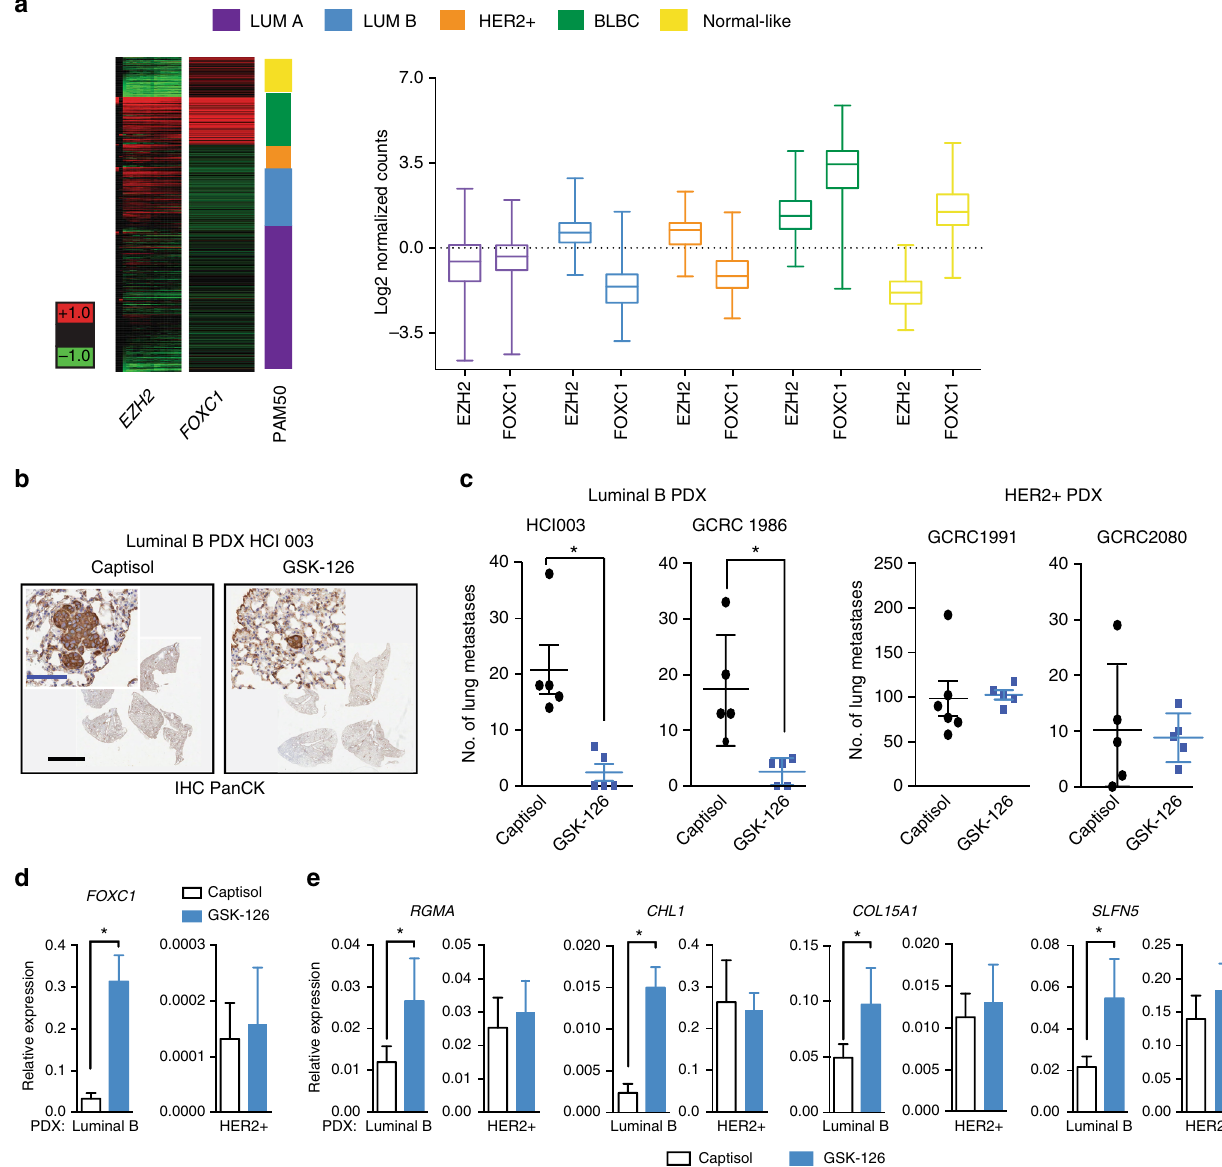
Fig. 7 Inhibition of Ezh2 methyltransferase activity reduces the metastatic capacity of Luminal B but not HER2 breast cancer. a FOXC1 or EZH2 transcript levels across different PAM50 subtypes of breast cancer represented in a heat map. Turkey box plots showing median EZH2 or FOXC1 levels across different breast cancer subtypes. Data is from the TCGA Breast Cancer data set, publicly accessible via the XENA UCSC Cancer Genome Browser. Dotted Red outline denotes Luminal B subset. Normal-like (yellow), n = 119, EZH2 s.d = 0.72, mean = 1.54, FOXC1 s.d = 1, mean = − 1.64. BLBC (green), n = 142, EZH2 s.d = 0.81, mean = 1.3, FOXC1 s.d = 1,27, mean = 3.18. HER2 (orange), n = 67, EZH2 s.d = 0.73, mean = 0.63, FOXC1 s.d = 0.84, mean = − 1.13. Luminal A (purple), n = 434, EZH2 s.d = 1.08, mean = − 0.64, FOXC1 s.d = 0.83, mean = − 0.44. Luminal B (blue) n = 194, EZH2 s.d = 0.65, mean = 0.60, FOXC1 s.d = 0.89, mean = − 1.64. Whiskers for the plots signi fi y s.d, while the bar denotes the mean for each subtype. b Representative images of paraf fi n-embedded sections of lung stained with pan cytokeratin (pan CK). Lung lesions were identi fi ed by pan CK positivity and enlarged nuclei. Top scale bar is 200 μ m. Bottom scale bar is 5 mm. c Quanti fi cation of lung lesions following the implantation of Luminal B PDX (HCI003) or HER2 + PDX (GCRC1991) into the mammary fat pad, followed by treatment with GSK-126 or vehicle (Captisol). N = 5 per condition. * p < 0.05, 1 tailed t -test. d qRT-PCR analysis of FOXC1 transcript levels in endpoint Luminal B ( n = 4 per condition) or HER2 + ( n = 4 per condition) PDX tumours treated with GSK-126 or vehicle long term in vivo. * p < 0.05, 1 tailed t-test. e qRT-PCR analysis of 4 FOXC1 targets in in endpoint Luminal B ( n = 4 per condition) or HER2 + ( n = 4 per condition) PDX tumours treated with GSK-126 or vehicle long term in vivo. * p < 0.05, 2 tailed t